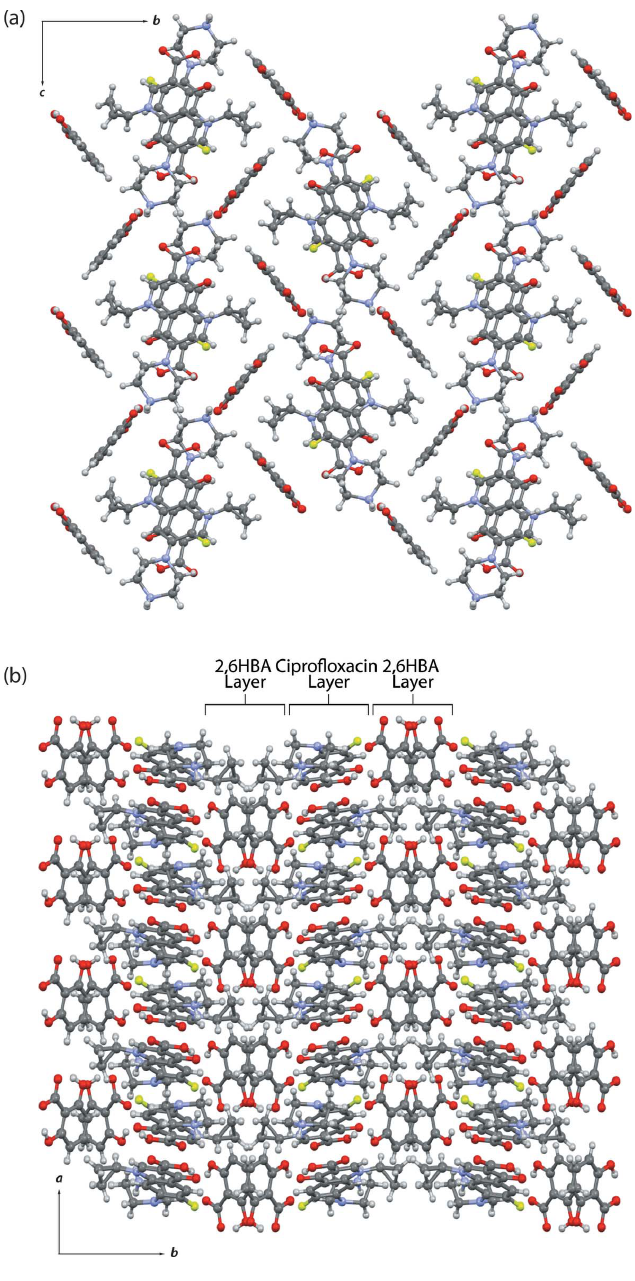
Figure 5 Packing motifs of (I) viewed along ( a ) the a axis and ( b ) the c axis highlighting the alternating layers of ciprofloxacin and the coformer.